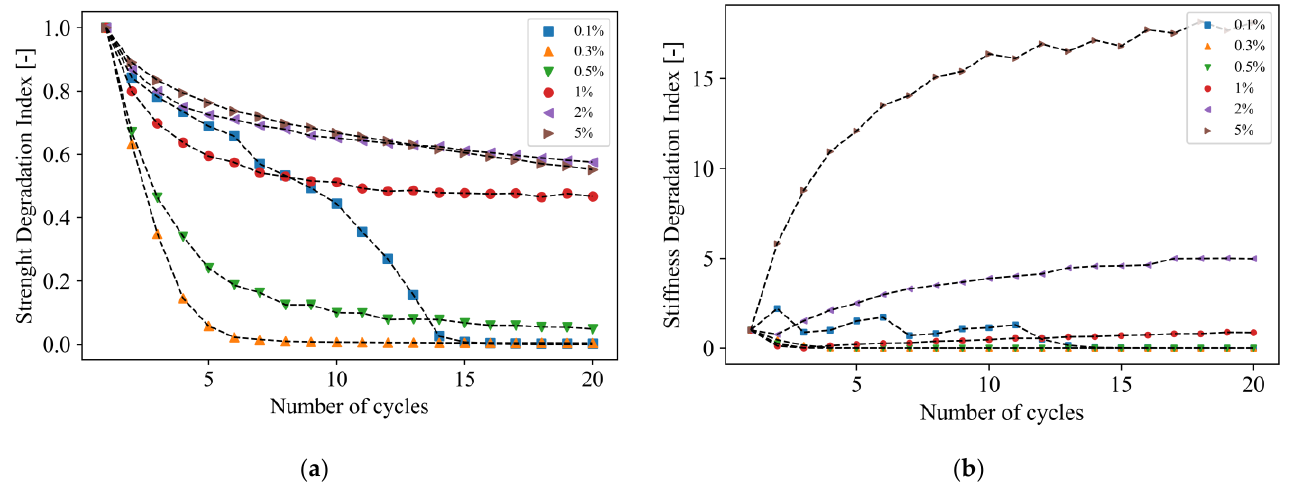
Figure 10. Cyclic Degradation Curves for the medium-dense sand samples: ( a ) degradation of the soil strength; ( b ) degradation of the soil stiffness expressed as initial tangent shear modulus.